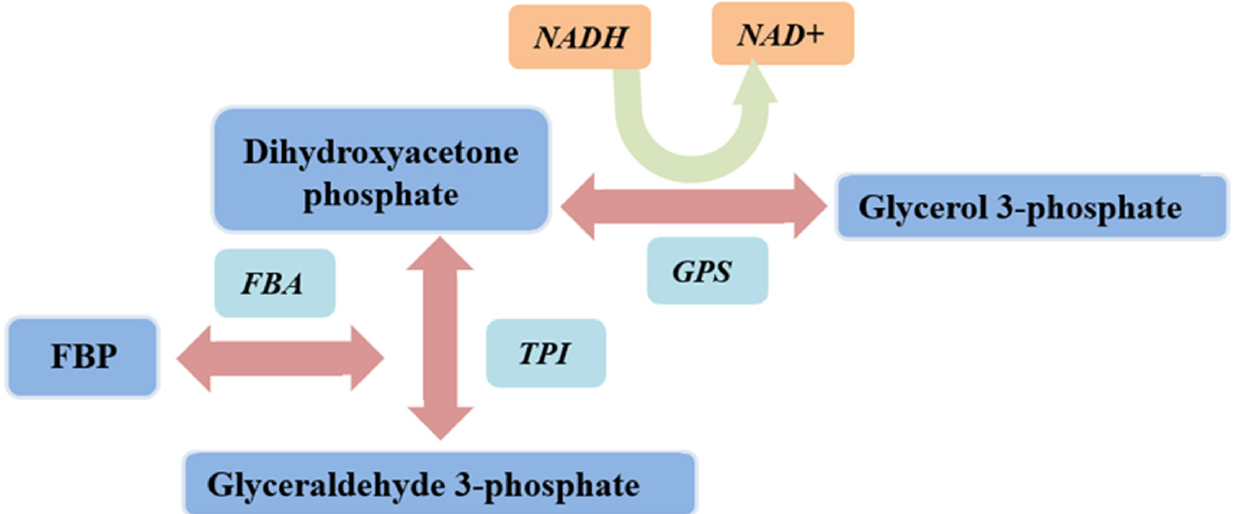
Figure 9. Catalytic processes involving fructose-1,6-bisphosphate aldolase. FBA reversibly catalyzes the cleavage of FBP to DHAP and G3P, where G3P is converted to DHAP via TPIase and DHAP is converted to glycerol 3-phosphate by GPS. NADH is converted to NAD+ in the process.